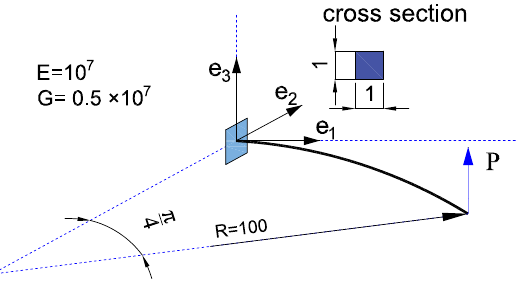
Figure 3. Curved cantilever beam: geometry, load, and boundary